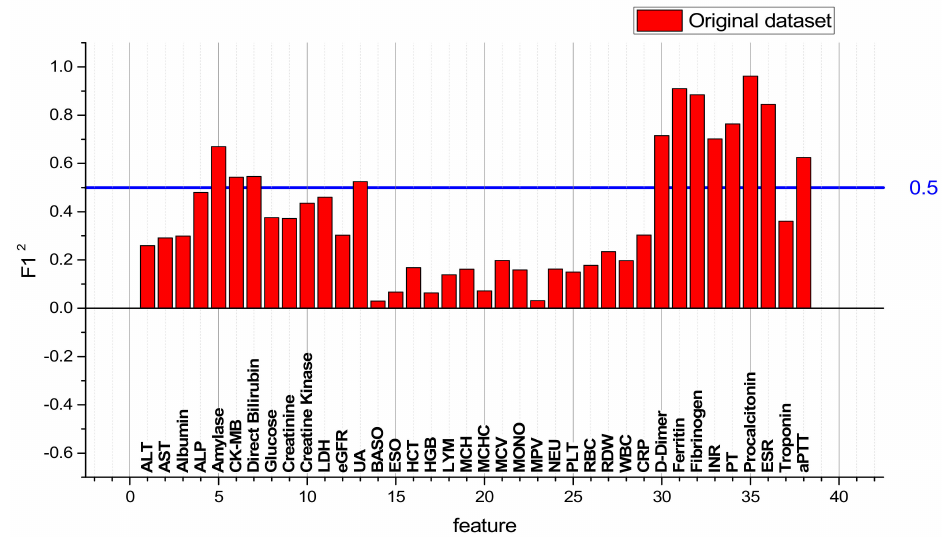
Figure 6. F1 2 metric of the HGB model according to each feature for the detection of surviving and non-surviving COVID-19 patients.